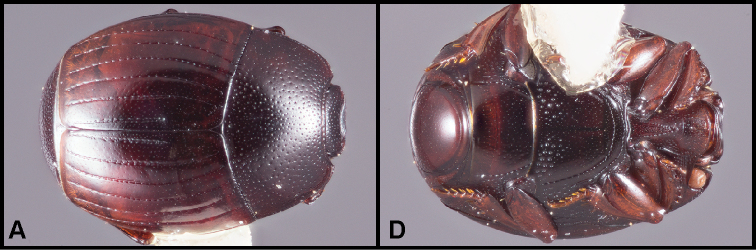
A-BPhelisterpuncticollis Hinton: A Dorsal habitus B Ventral view.